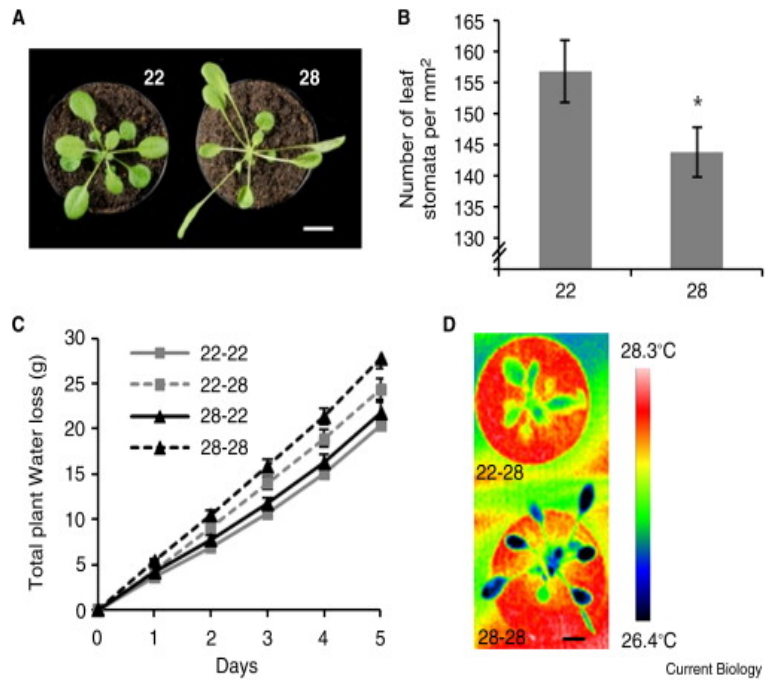
Figure 3. Crop responses at high temperatures indicate an increase in transpiration and enhanced leaf cooling capacity. ( A ) shows the plant at two different temperature levels and the thermal image of this condition is shown in ( D ), ( B ) proves the increasing number of leaves at lower temperature with respect to the lower value of water loss as shown in ( C ).